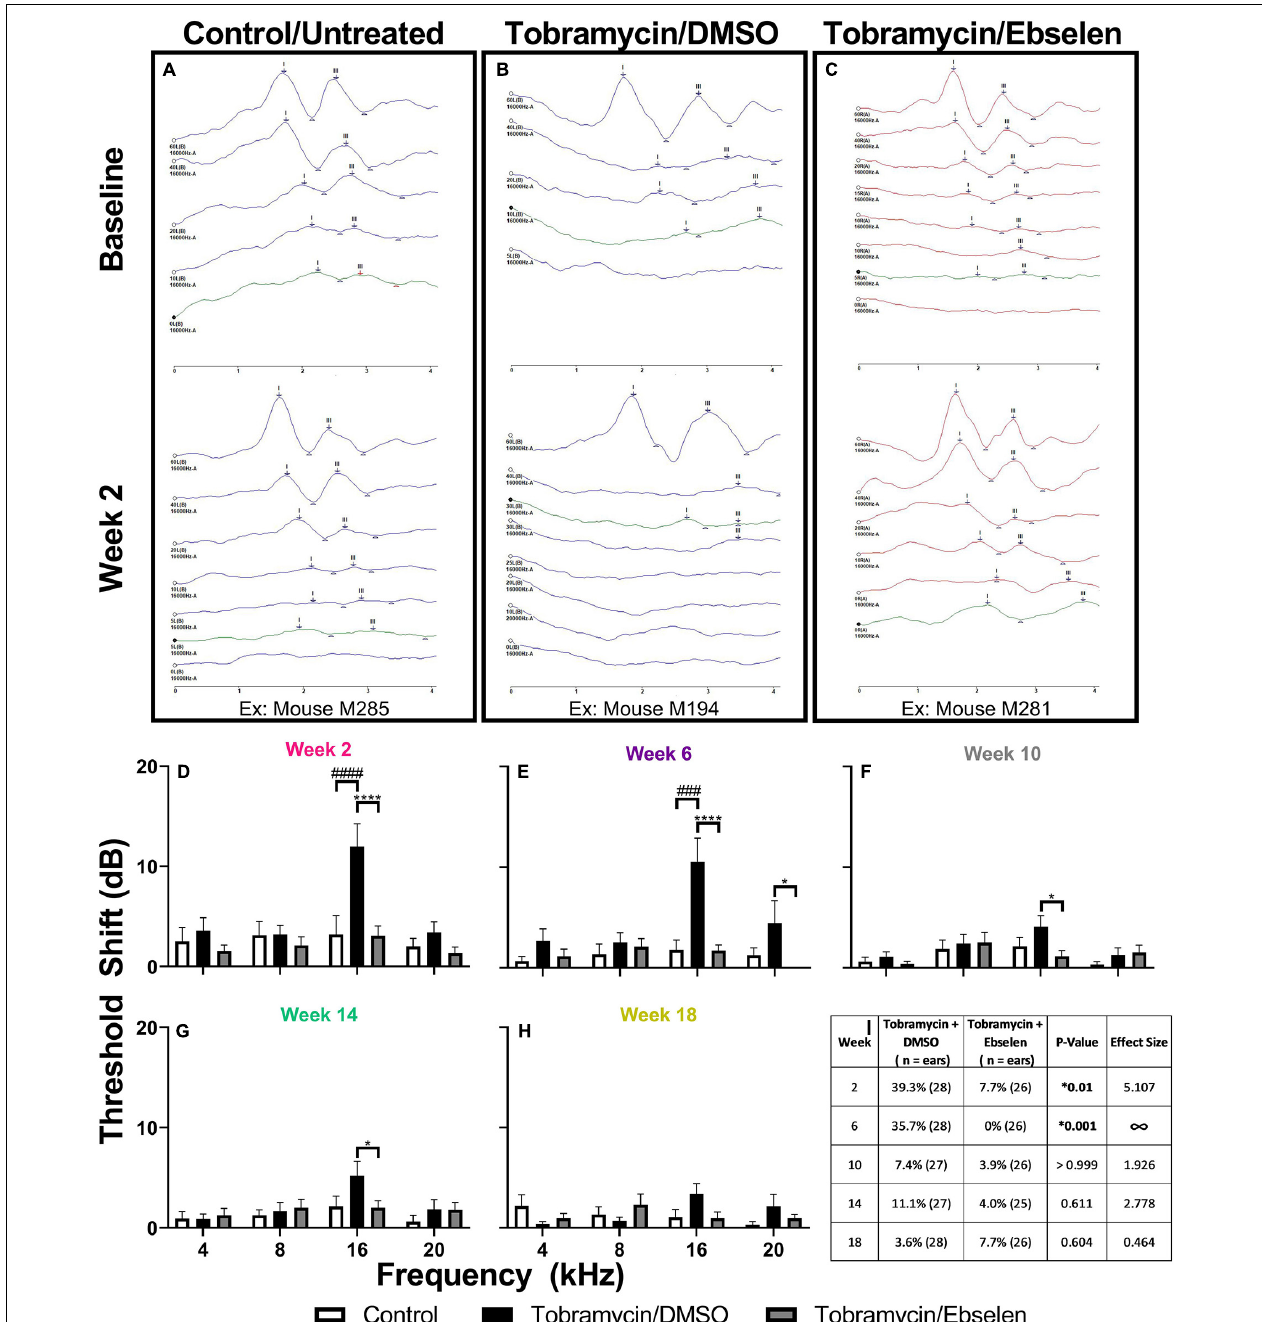
FIGURE 2 | Evaluation of hearing loss caused by tobramycin. ABR traces from 16 kHz stimuli collected at baseline and 2 weeks after the start of treatment showing impact of tobramycin on hearing thresholds ( (A) : untreated control, (B) : tobramycin/DMSO, (C) : tobramycin/ebselen). Blue and red traces show ABRs from left and right ears, respectively. Green trace in each panel represents threshold. Averaged tobramycin-induced ABR threshold shifts comparing testing groups at different epochs ( (D): week 2, (E): week 6, (F): week 10, (G): week 14, (H): week 18) after the start of treatment. ABRs were collected for 4, 8, 16, and 20 kHz. Shifts represent the specific epoch minus the baseline ABR value for each group. Data is represented by threshold shift means and standard errors. Post hoc tests determined significant differences between testing groups, which are indicated as follows: # (black), between control and DMSO treated animals; # (gray), between control and ebselen treated animals; *, between DMSO and ebselen treated animals. (I): Clinically relevant change criteria table. (1) Criterion for CRC: A ≥ 20 dB shift at one frequency. (2) A ≥ 15 dB shift at two adjacent frequencies. (3) A ≥ 10 dB shift at three adjacent frequencies. Each ear was analyzed independently. The percentage of ears which met the ABR threshold shift criteria was calculated for each time point (weeks 2, 6, 10, 14, 18). Two-sided Fisher’s exact tests were used statistically evaluate differences between testing groups. The effect size represents relative risk (Koopman asymptotic score).